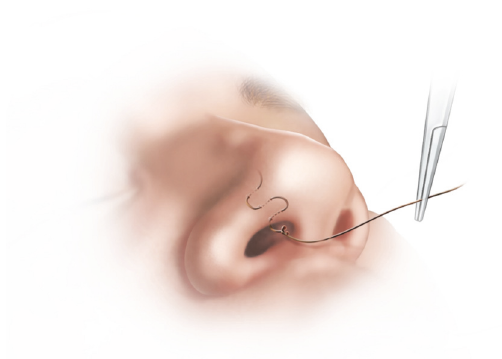
Figure 2: Step 2. A series of passes are made through the septum, each around 1cm posterior to the previous one, until the anterior margin of the MT is